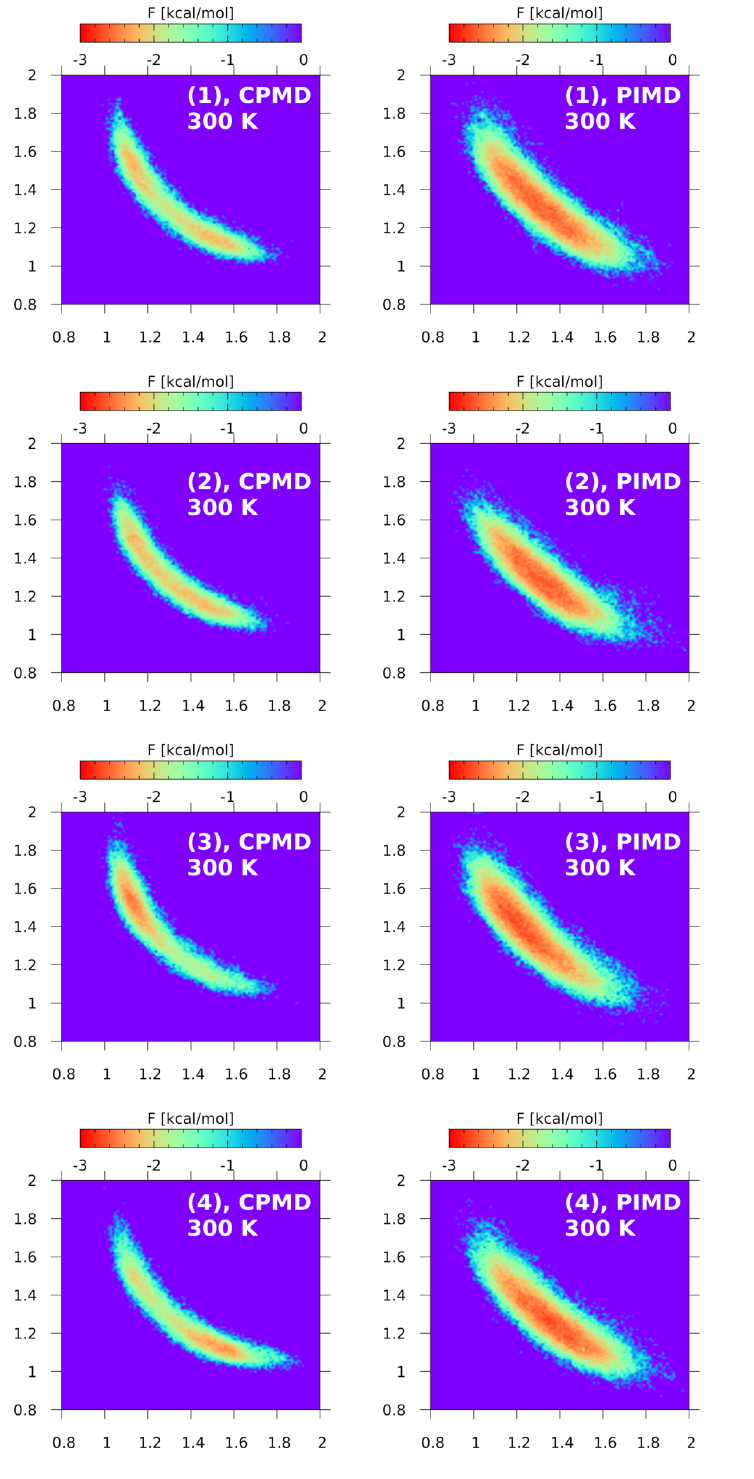
Figure 8. Free energy surface for proton motion in the compounds (1)–(4)-comparison of gas phase simulations at 300 K with classical (CPMD) and quantum (PIMD) nuclear regime. The axes are the N ··· H distances—the horizontal axis for the donor-H and the vertical axis for the acceptor-H distances in